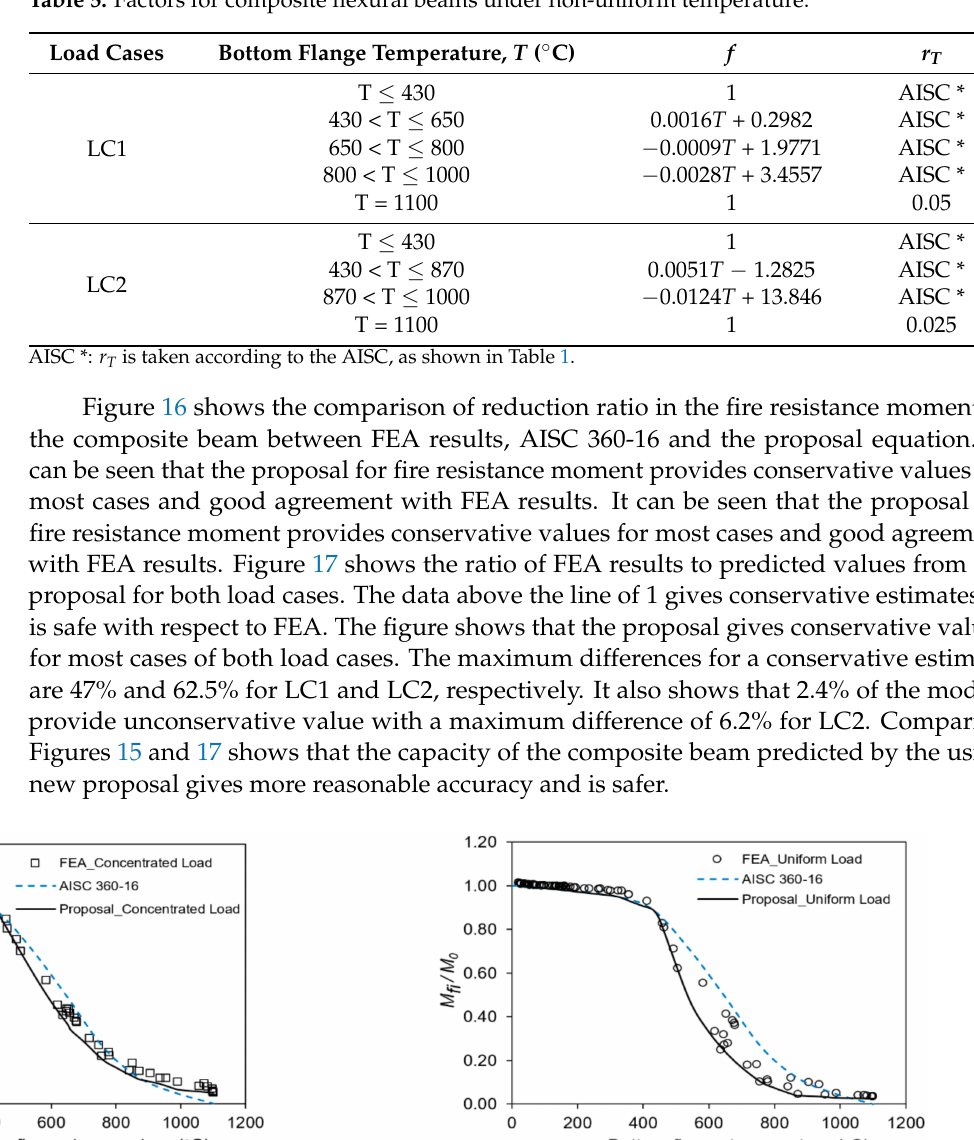
Table 5. Factors for composite flexural beams under non-uniform temperature.